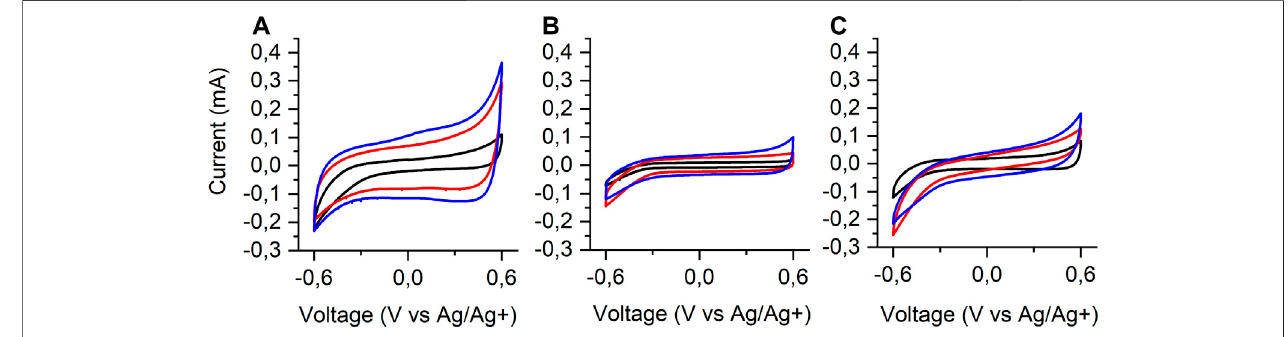
FIGURE 4 | Cyclic voltammograms of Mixtures A, B and C in aqueous NaCl (0.1 M) at a scan rate of 20 mV/s for different electrospinning times: 700 ( ▬ ), 1,000 ( ▬ ) and 1,500 s ( ▬